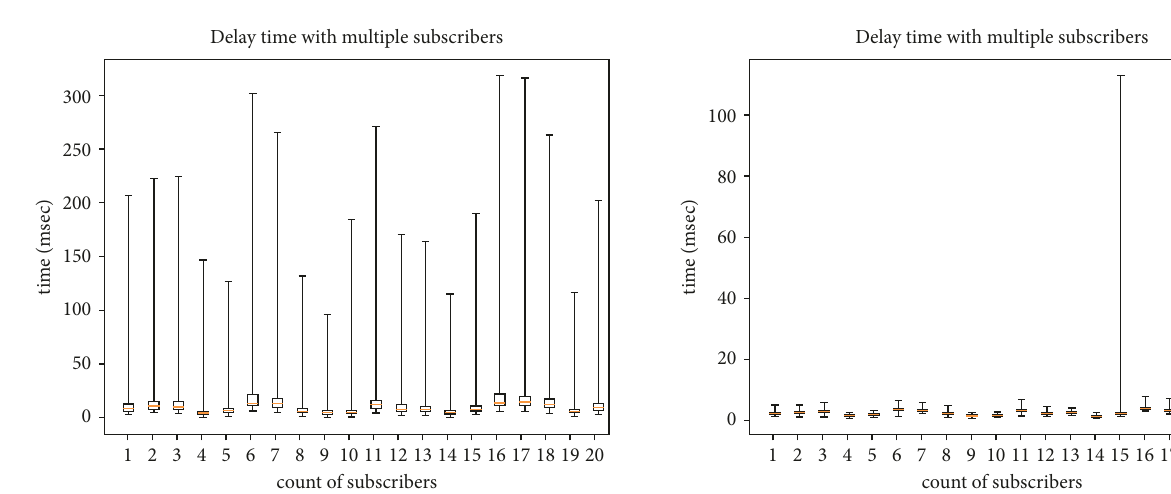
Figure 5: GlassFish’s delay boxes with different subscriber counts.